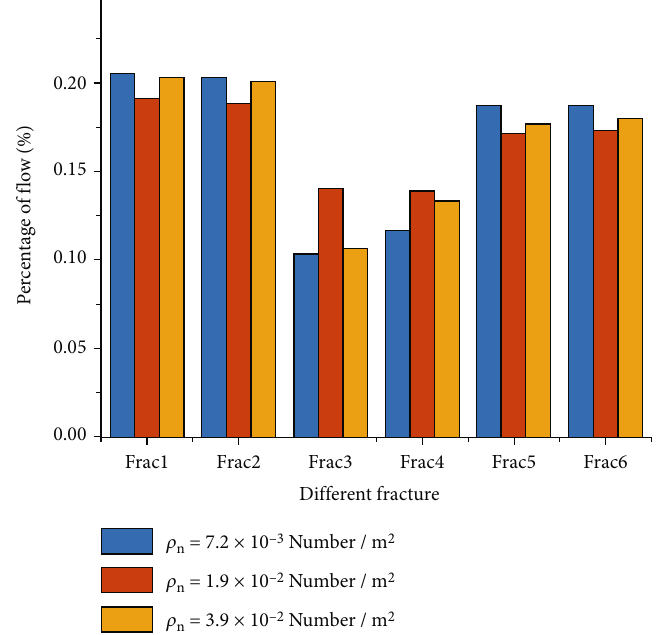
Figure 22: Fracture network morphology for varying natural fracture densities. (a) ρ number/m 2 , and (c) ρ = 3 : 9 × 10 − 2 number/m 2 . n